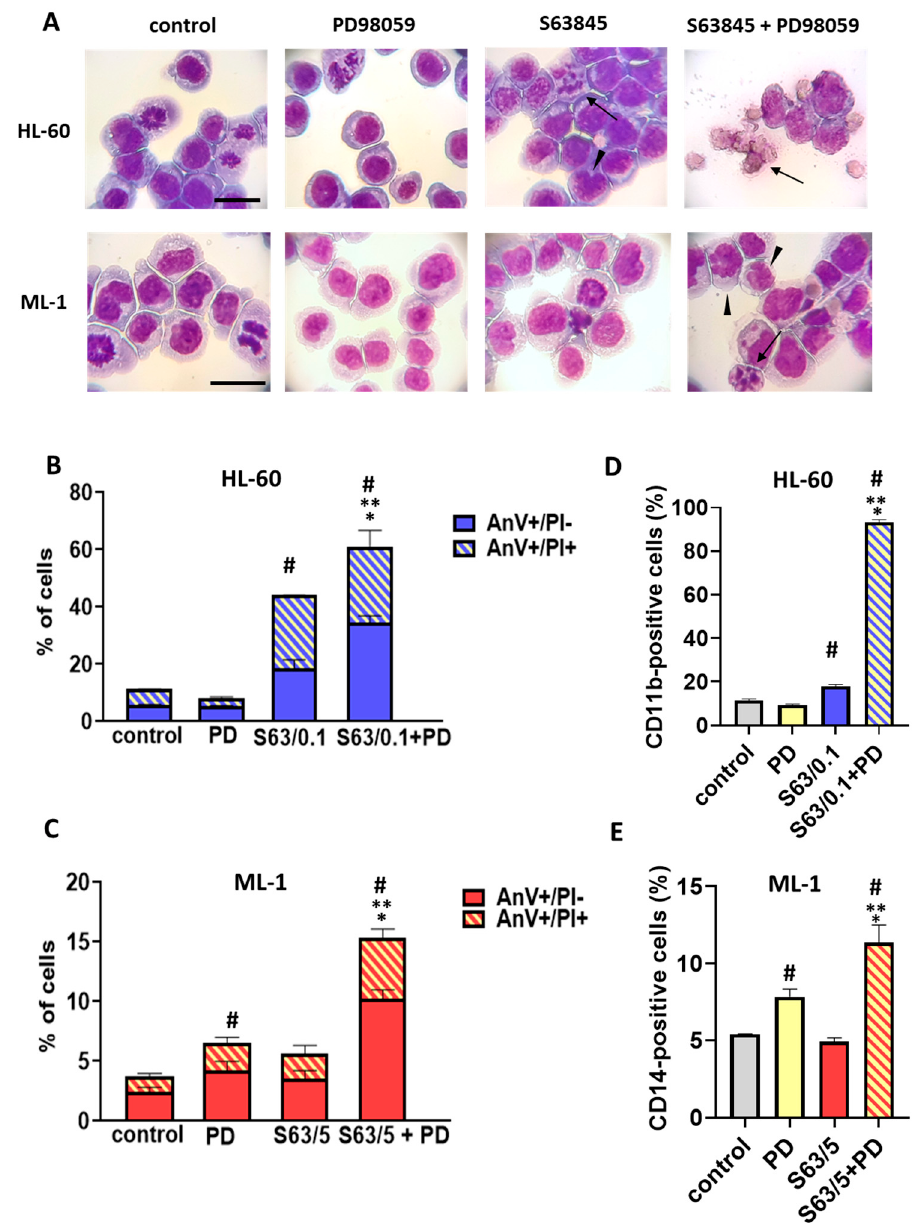
Figure 8. Effects of S63845 (S63) and MAPK inhibitor PD98059 (PD) applied alone or in combination on apoptosis and differentiation of AML cells. ( A ) Representative micrographs of leukemic cells stained with Hemacolor demonstrating cells with characteristic features of apoptosis (arrows) and differentiation (arrowheads) (original magnification 1000 × , scale bar = 20 µ m). Apoptosis was determined in HL-60 ( B ) and ML-1 ( C ) cells by flow cytometry Annexin V-FITC/propidium iodide assay 48 h after agent application. The effects of S63845 and PD98059 on the differentiation of AML cells were evaluated after 48 h cell exposure to the tested agents. ( D ) The percentages of CD11b-positive HL-60 cells and ( E ) the percentage of CD14-positive ML-1 cells were analyzed using fl ow cytometry. Designations 0.1 and 5 indicate the S63845 concentrations (µM). Values are reported as the means ± SD of three independent experiments. Values signi fi cantly di ff erent ( p ˂ 0.05) according to one-way ANOVA are designated by * and ** compared to, respectively, S63845 or PD98059—single treated group; # compared to the corresponding control.